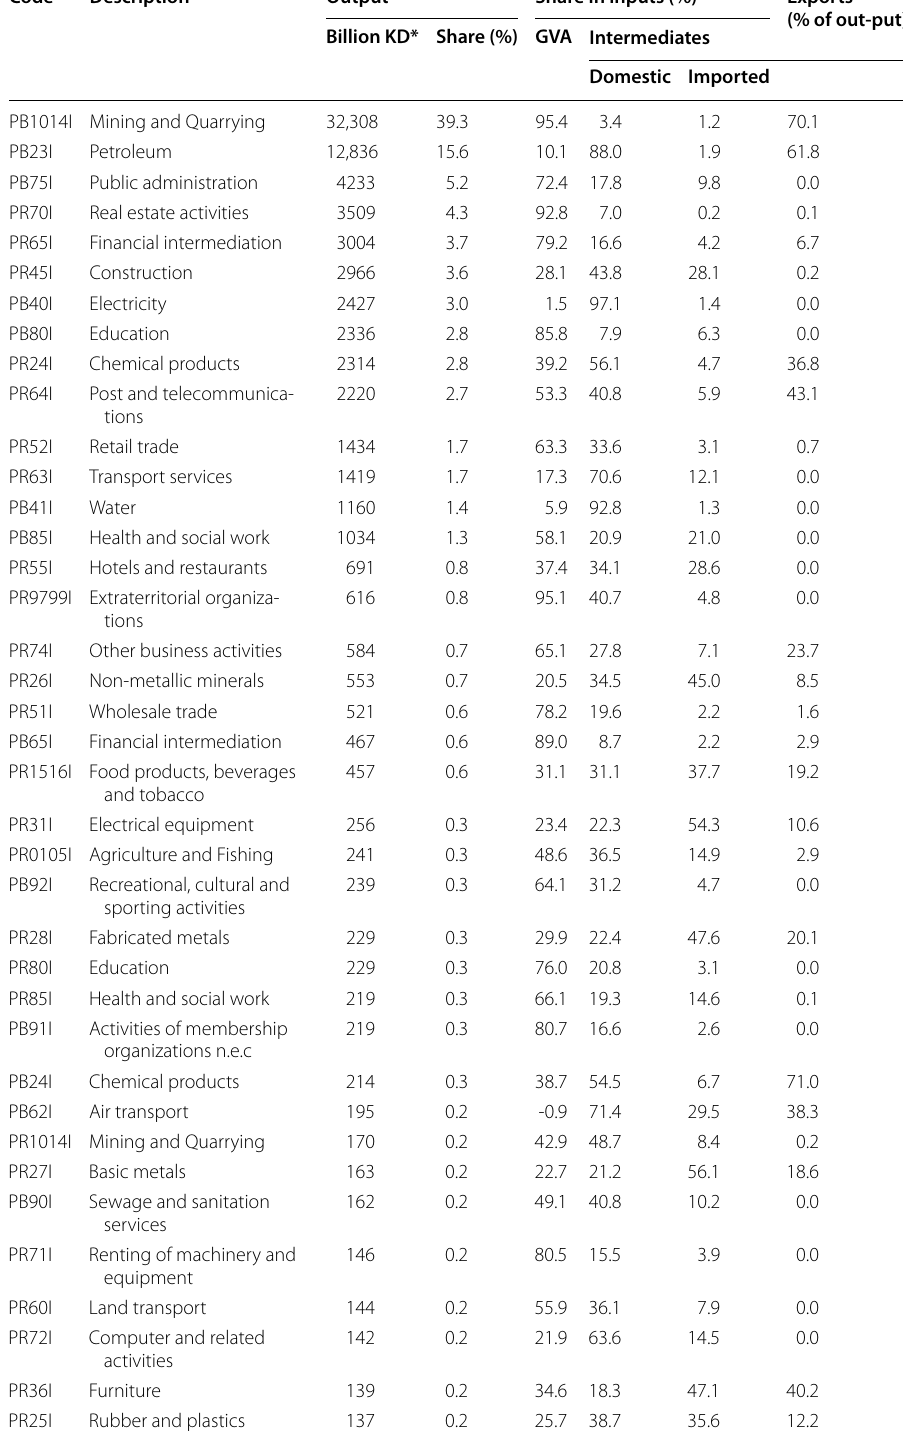
Table 2 Input and output shares of public and private sectors in the Kuwaiti economy (2013). Source: computed by the authors based on CSB (2013) and supplementary data customized specifically for this